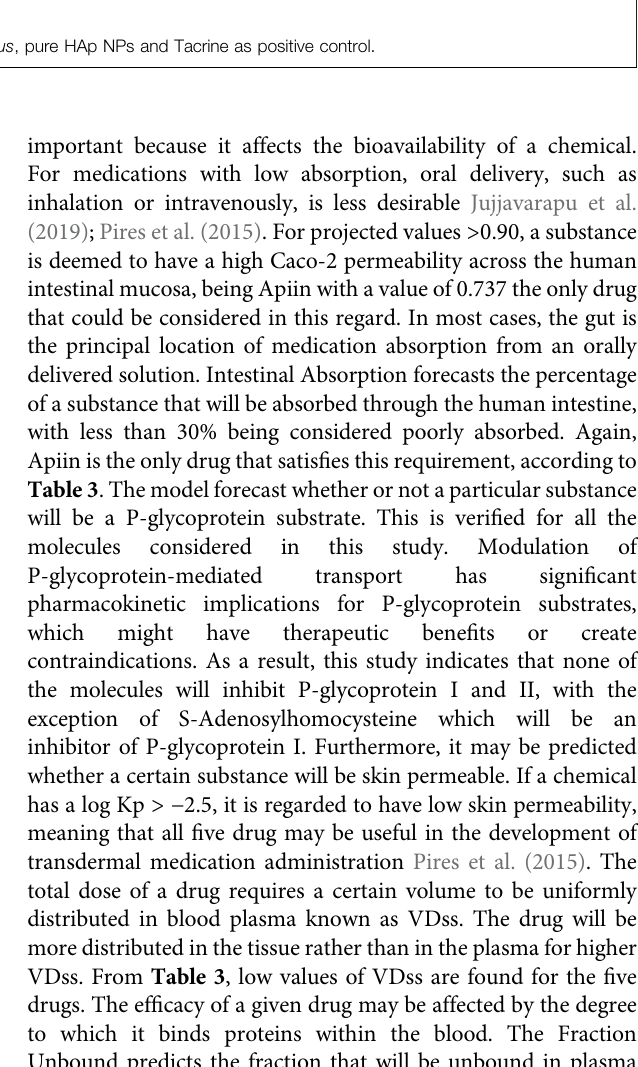
Frontiers in Chemistry |